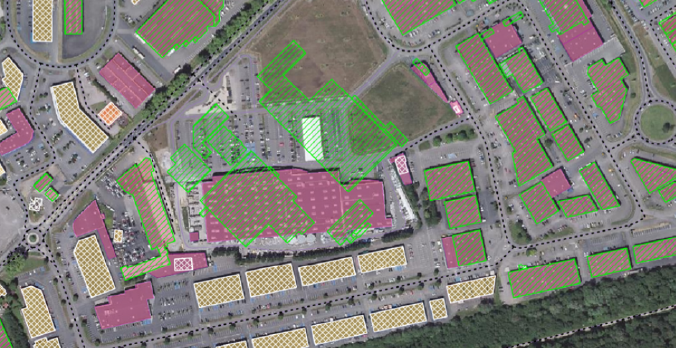
Figure 4. Temporal snapshots overlapped with an orthophotograph from 2020. Buildings captured at different dates are shown with green and white strokes for 2004 and rose and beige solid color for 2019. Unless the terrain changes, they are perfectly identical from one database version to the